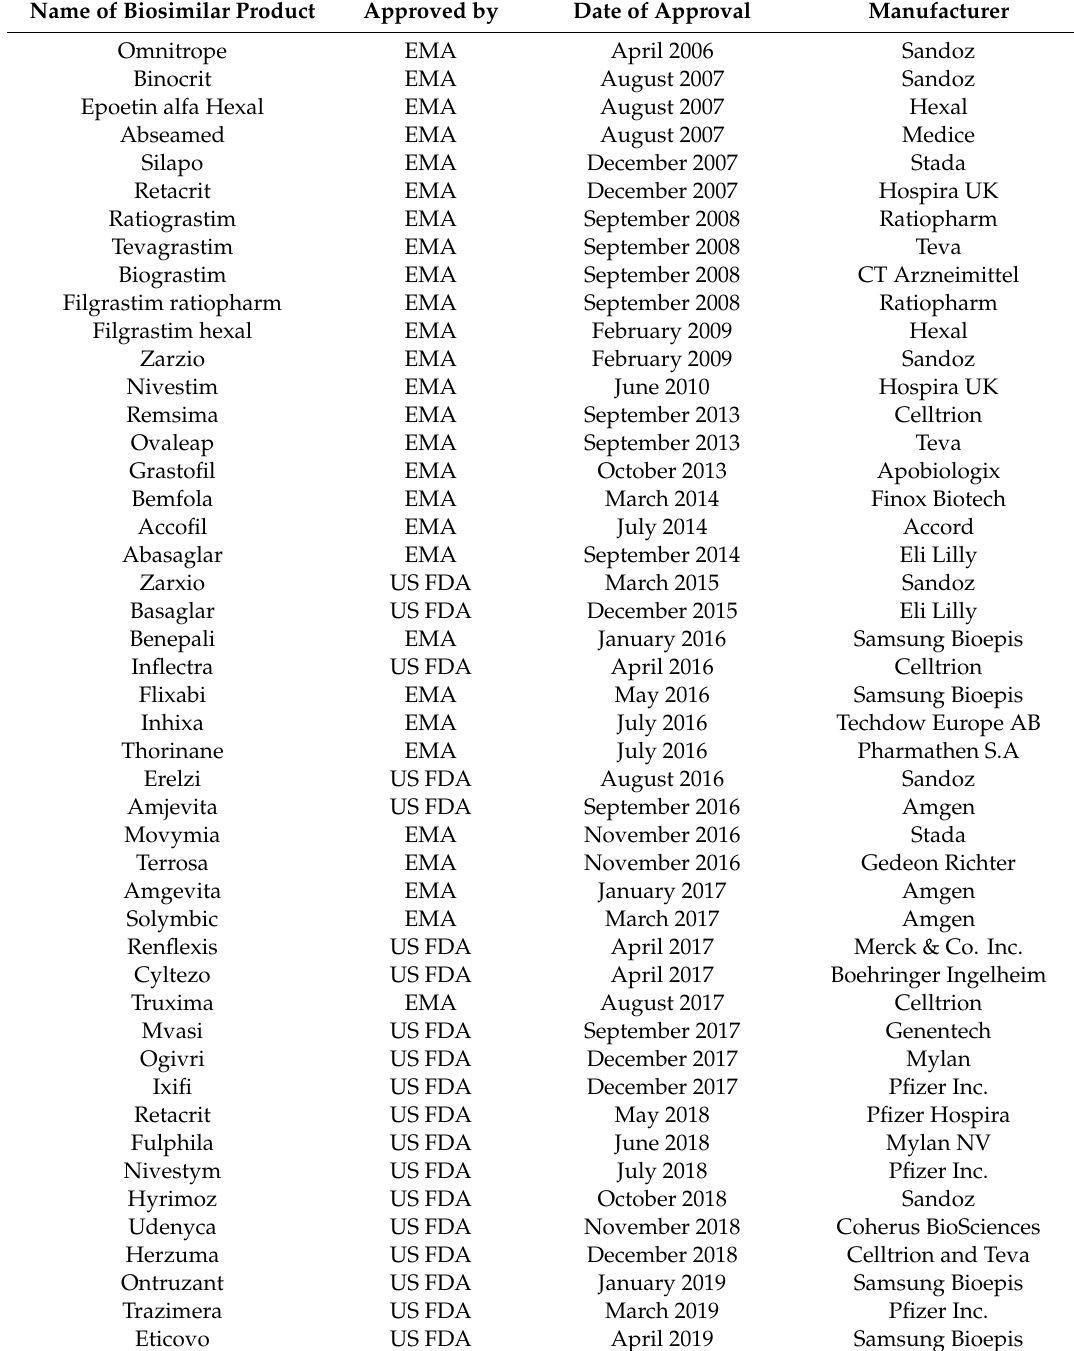
Table A1. List of Biosimilars approved till 2019 by US FDA and